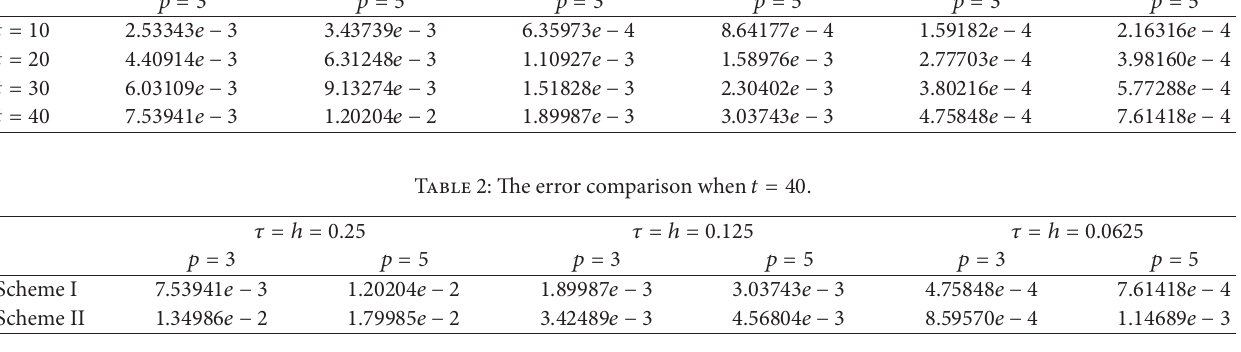
Table 3: The verification of the second convergence.